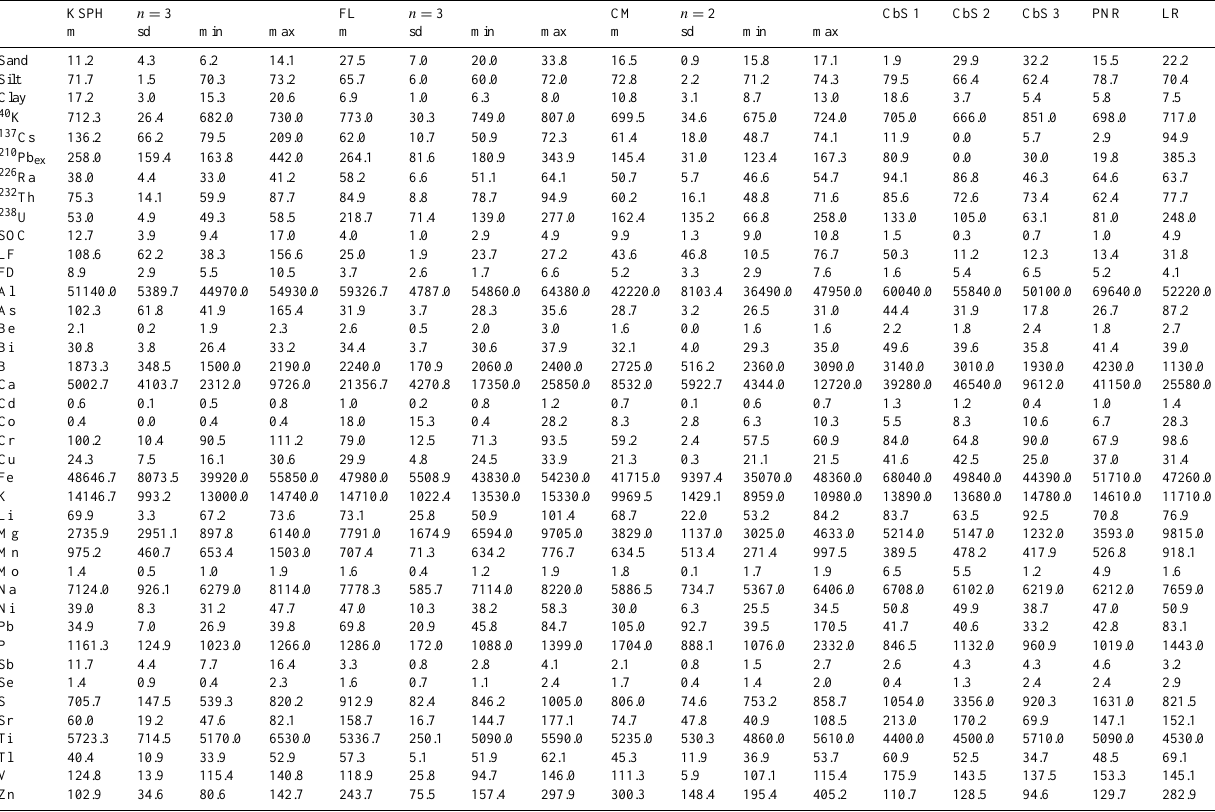
Table 3. Statistics measures of the tracer properties for the potential sediment sources (KSPH: Kastanozems/Phaeozems; FL: Fluvisols; and CM: Cambisols) and targets (units: textural classes: %; radionuclide: Bqkg − 1 ; low frequency mass specific magnetic